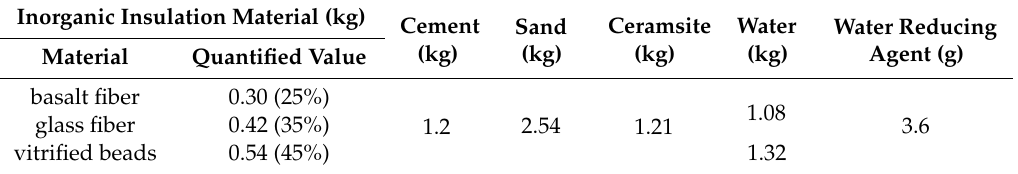
Table 6. Material dosage table.